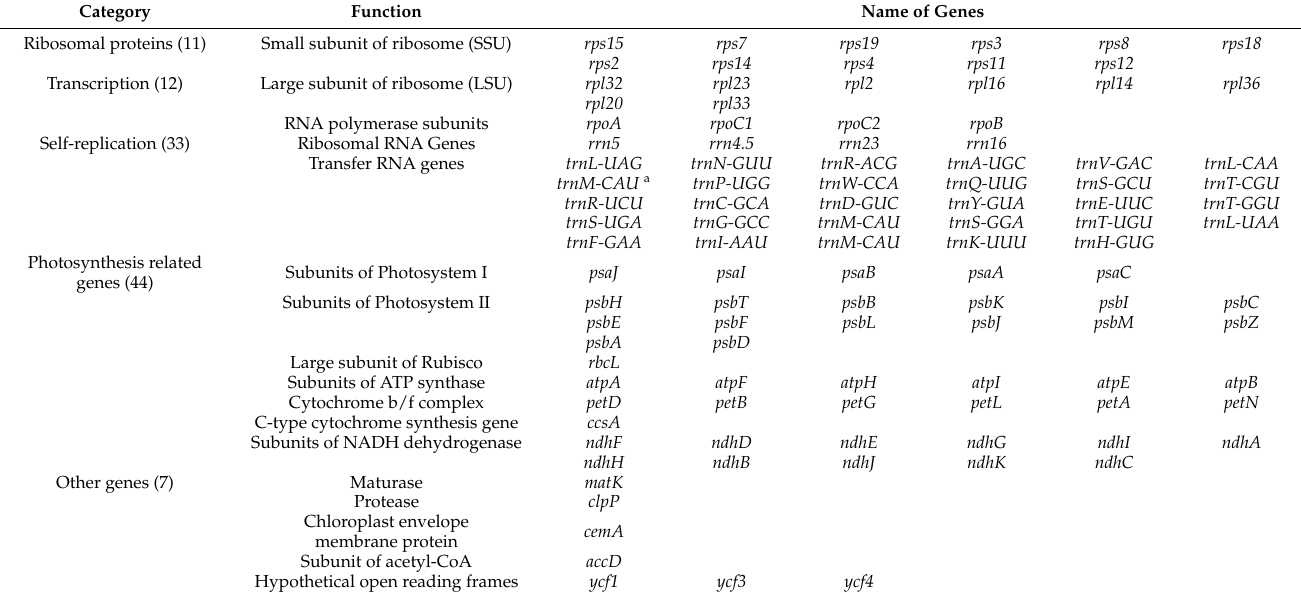
Table 2. Genes predicted in the chloroplast genome of Galega orientalis .